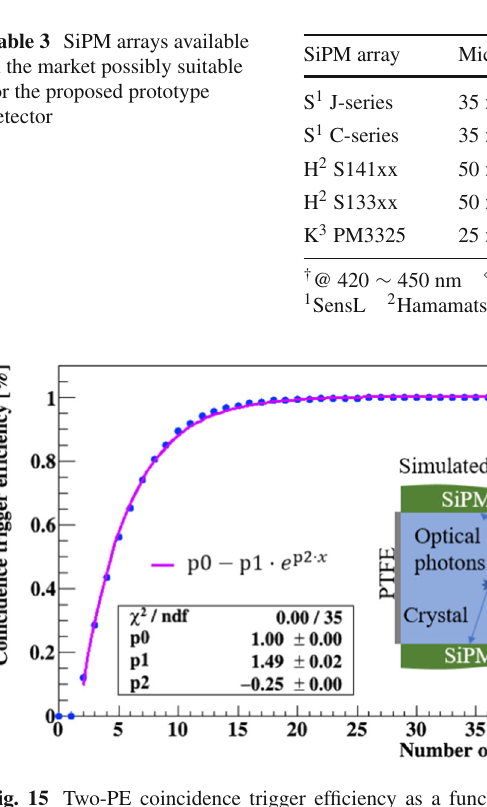
Fig. 15. Based on the curve, the trigger efficiency is about 50% at 40